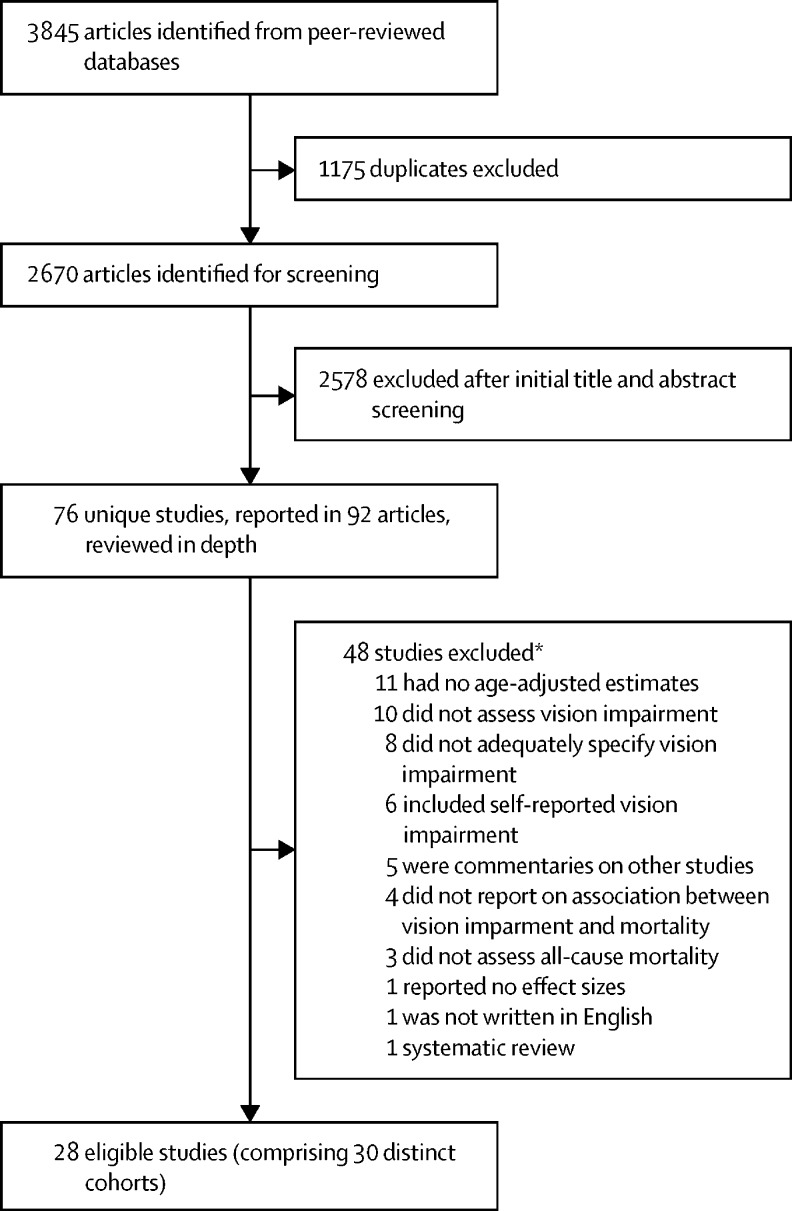
Study selection*Some studies were excluded for more than one reason.